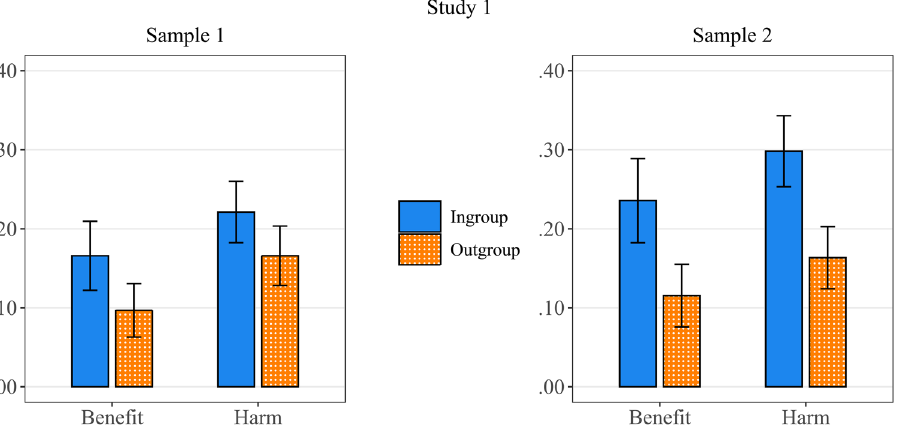
Figure 1. Proportion of outcome Maximizing choices as a function of target group (Ingroup versus Outgroup) and type of outcome (Benefit versus Harm). The error bars represent 95% confidence